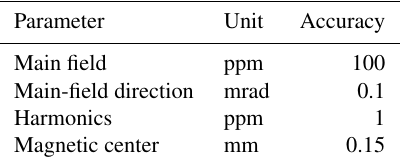
Table 1. The target accuracy for LHC insertion region quadrupole measurements (Apollinari et al., 2017).